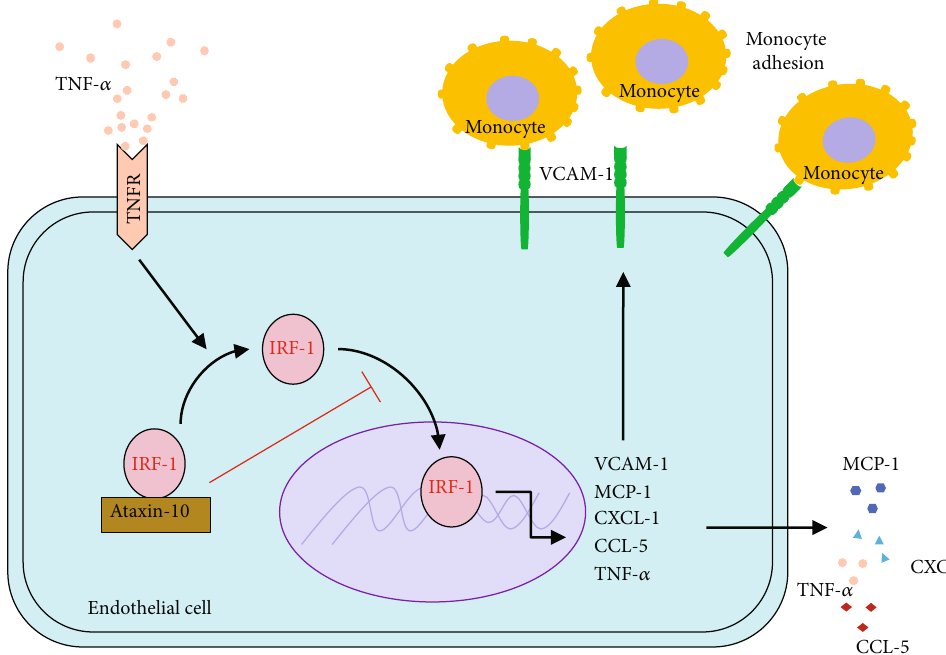
Figure 7: Graphic depiction of how Ataxin-10 suppresses TNF- α -induced VCAM-1 in endothelial cells via sequestering cytoplasmic